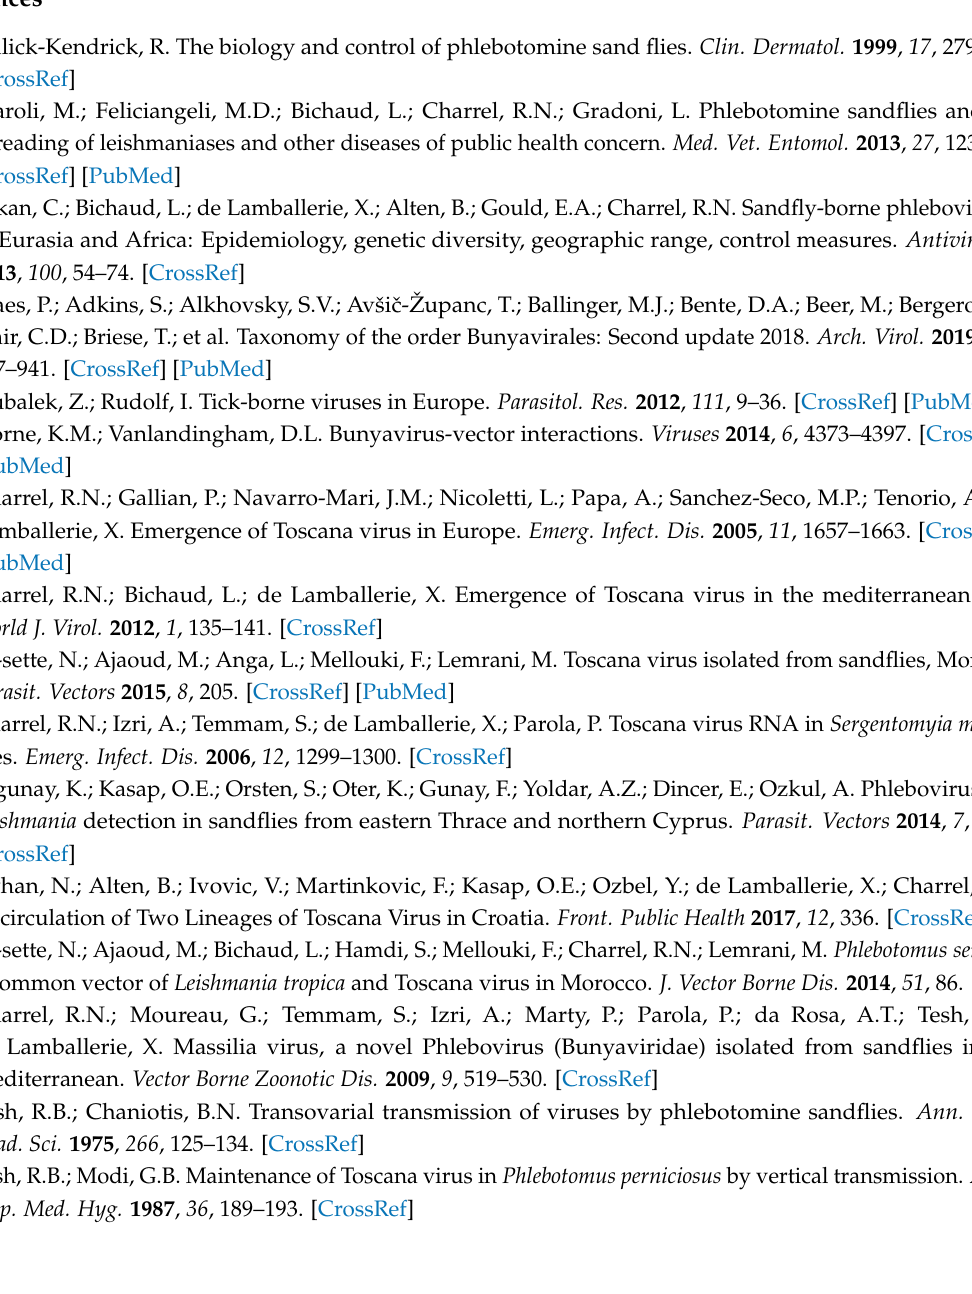
Figure S1: Susceptibility of females (grey bars) and males (black bars) of seven sand fly species to Massilia virus (MASV), Table S1: Phlebotomus perniciosus L1 infected with larval food (2 doses at D0 and D2), Table S2: Phlebotomus perniciosus L4 infected with larval food (one dose at D0), Table S3: P. perniciosus females infected by bloodmeal (one dose at D0), Table S4: Susceptibility of females of P. perniciosus , P. orientalis , P. papatasi , P. sergenti , P. argentipes